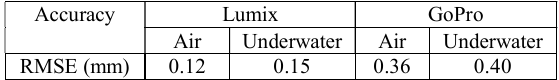
Table 3. Accuracy (RMSE) of camera systems in air and underwater computed from 33 check points at the reference